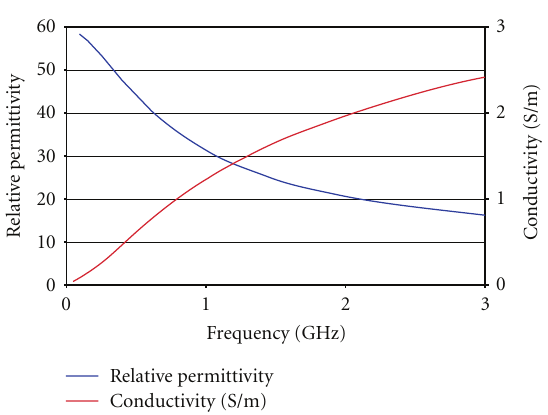
Figure 6: Dielectric properties of the 80 :20 glycerin :water bath.